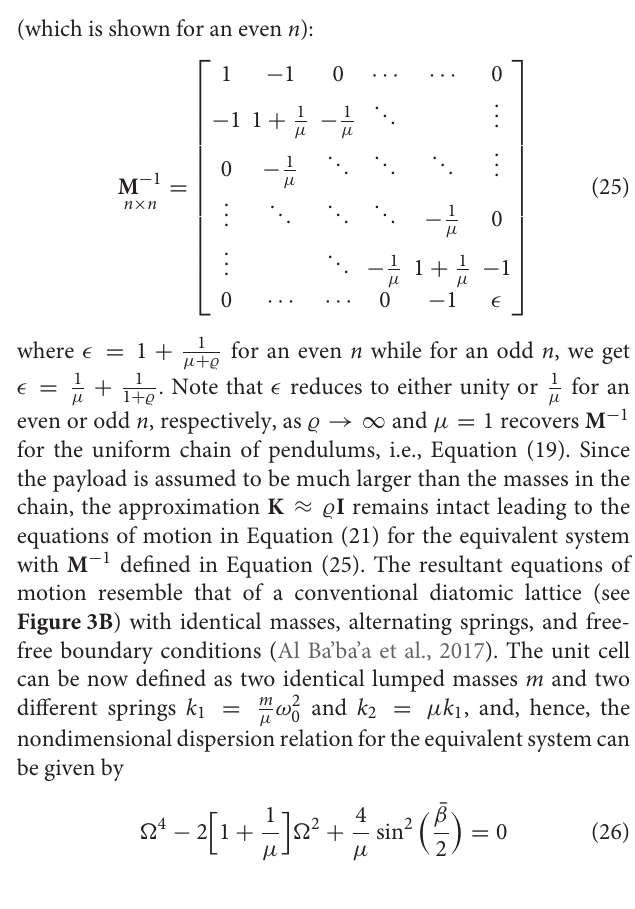
10 2 and (B) ̺ 10 3 for a uniform chain of pendulums with n = = 31) showing agreement with the analytical dispersion branch (black dashed-line) =